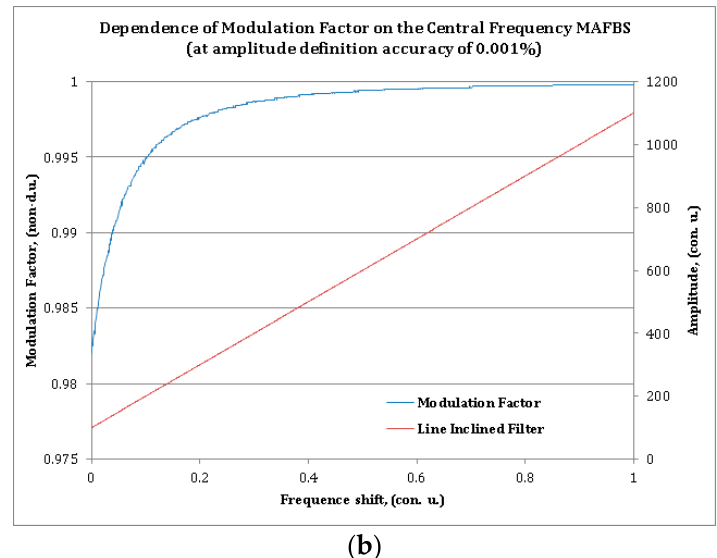
Figure 3. Modulation factor as the function of MAFBS central frequency shifting: The blue line is the dependence of the modulation factor; the red line is the spectral characteristic of the optic linear oblique filter, for an amplitude definition accuracy of ( a ) 0.01% and ( b ) 0.001%.